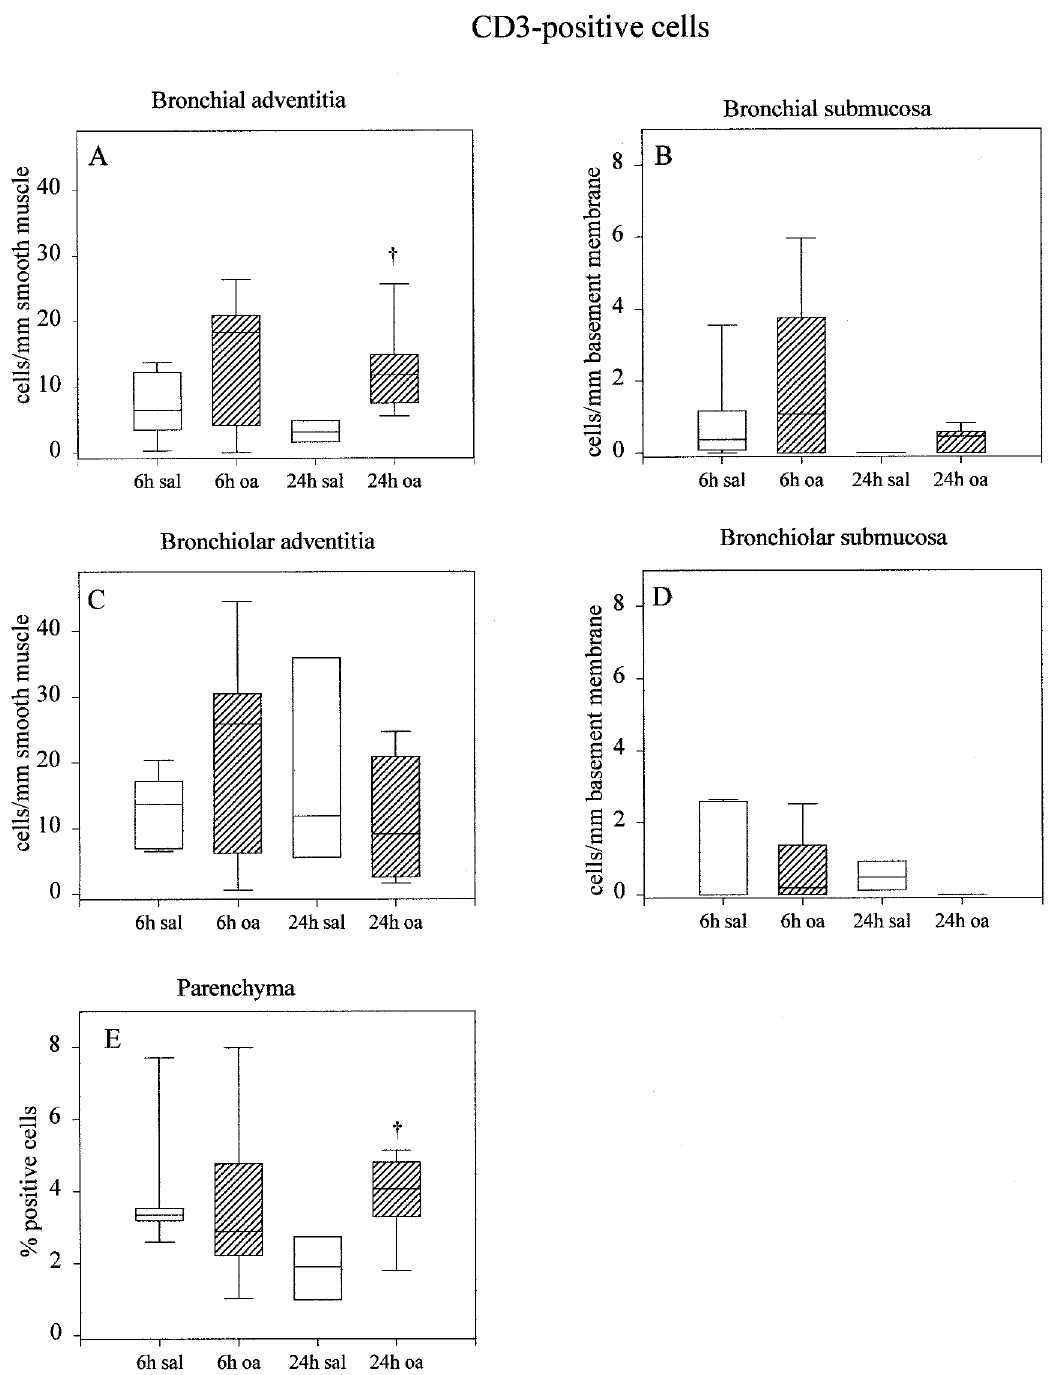
FIG. 5. Numbers of CD3 + cells at 6 and 24h after saline control inhalation (sal, open bars) or ovalbumin inhalation (oa, hatched bars) in different airway compartments. Data represent median values, interquartiles, and 10th and 90th percentiles of four to six animals. Statistical analysis: † p < 0.05, Mann–Whitney rank sum